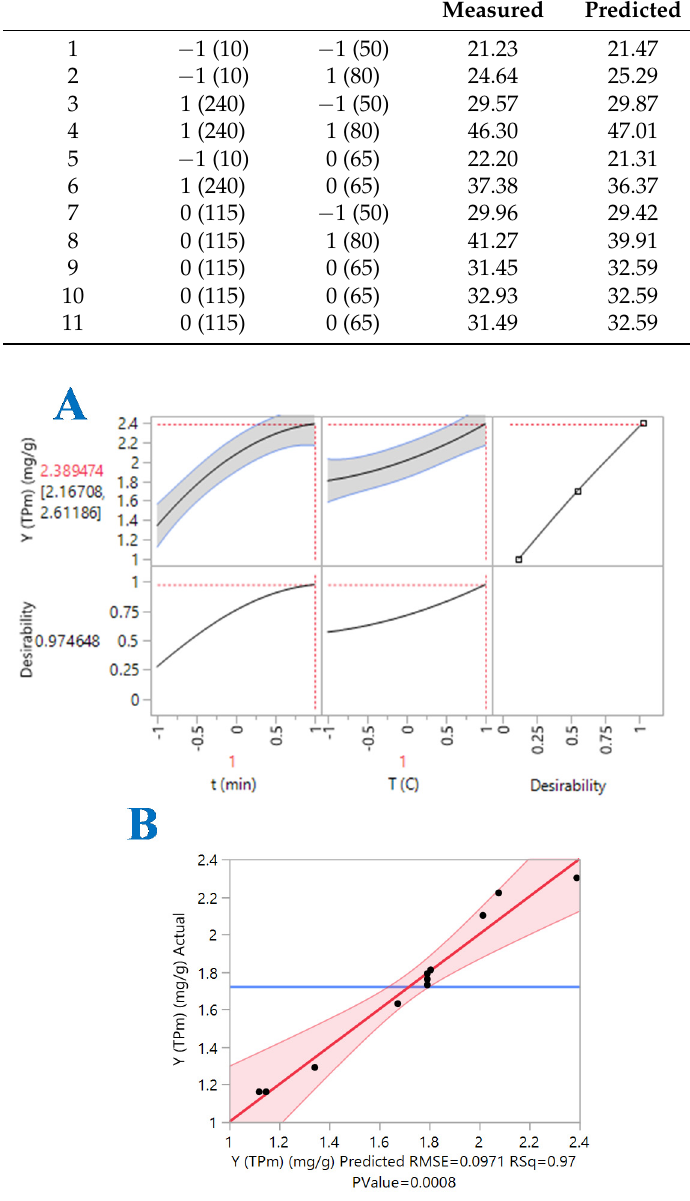
Figure 5. Statistical data on model fitting, accomplished with response surface methodology. ( A ) Desirability function showing optimal predicted values of both variables and maximum predicted Y TPm ; ( B ) actual-by-predicted plot.